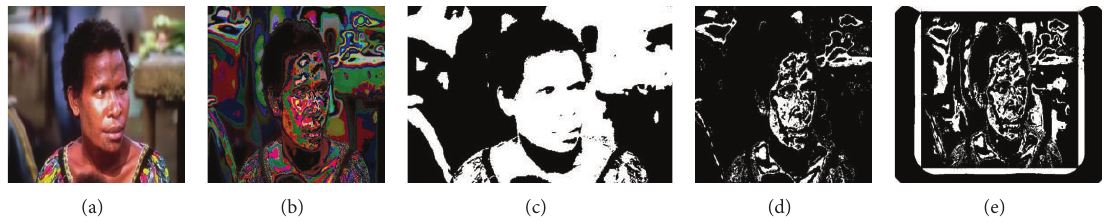
Figure 4: (a) Original image, (b) image of bit plane 6, (c) binarization of original image using mean threshold, (d) binarization of bit plane 6 with mean threshold, and (e) binarization of bit plane 6 with Niblack’s method of local